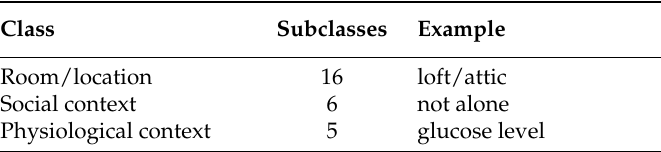
Table 4. Room/location, social context and physiological context classes in the SPHERE ADL